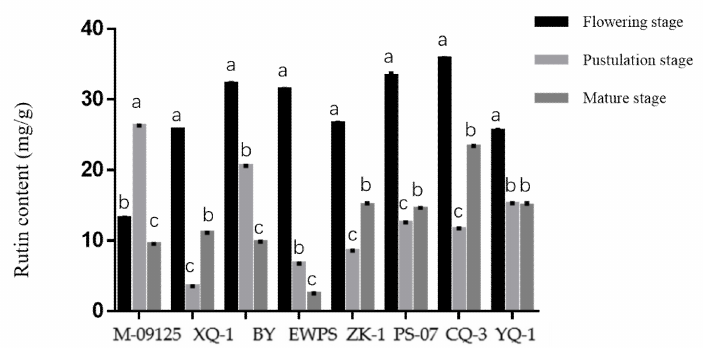
Figure 2. Rutin content of tartary buckwheat varieties at different growth stages. The value is rutin (mg) per gram dry matter basis. M-09125: Meng-09125; XQ-1: Xiqiao No. 1; BY: Buyue; EWPS: Ewu Pedgree selection; ZK-1: Zhaoku No. 1; PS-07: Pedgree selection-07; CQ-3: Chuanqiao No. 3 and YQ-1: Youqiao No. 1. Different lowercase letters on each column indicate significant differences between stages at p <